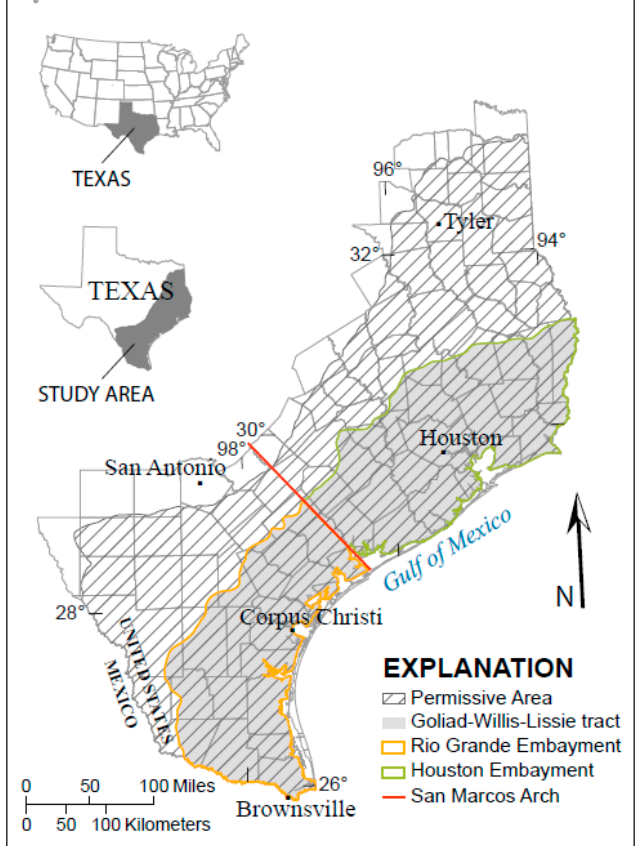
Figure 1. Map depicting the Texas Coast Plain. This study focused on the tract delineated by Mihalasky, Hall, and others 2015 [1] consisting of the Goliad Sand, Willis Sand, and Lissie Formation, permissive for the occurrence of undiscovered uranium resources, surficial alluvial sediments and associated above-ground areas and aquifer units. Shown also are the Houston and Rio Grande Embayments separated by the San Marcos Arch.